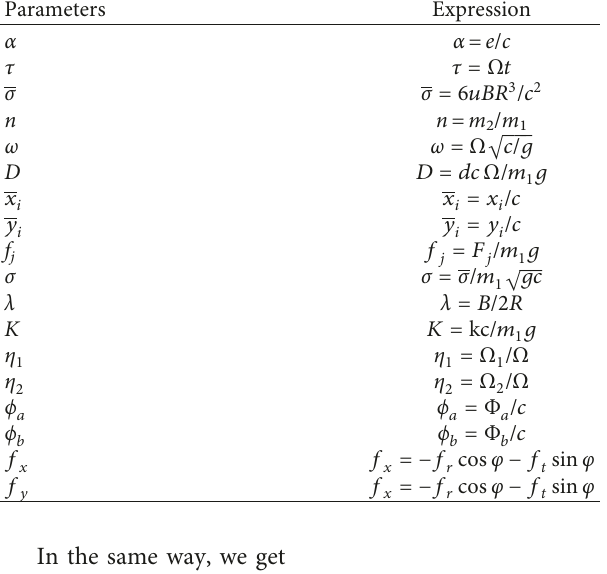
Table 1: The dimensionless expressions of the parameters. Parameters